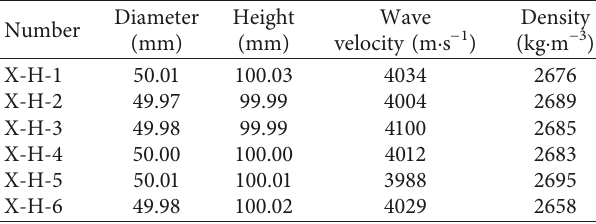
Table 1: Basic physical parameters of rock samples.